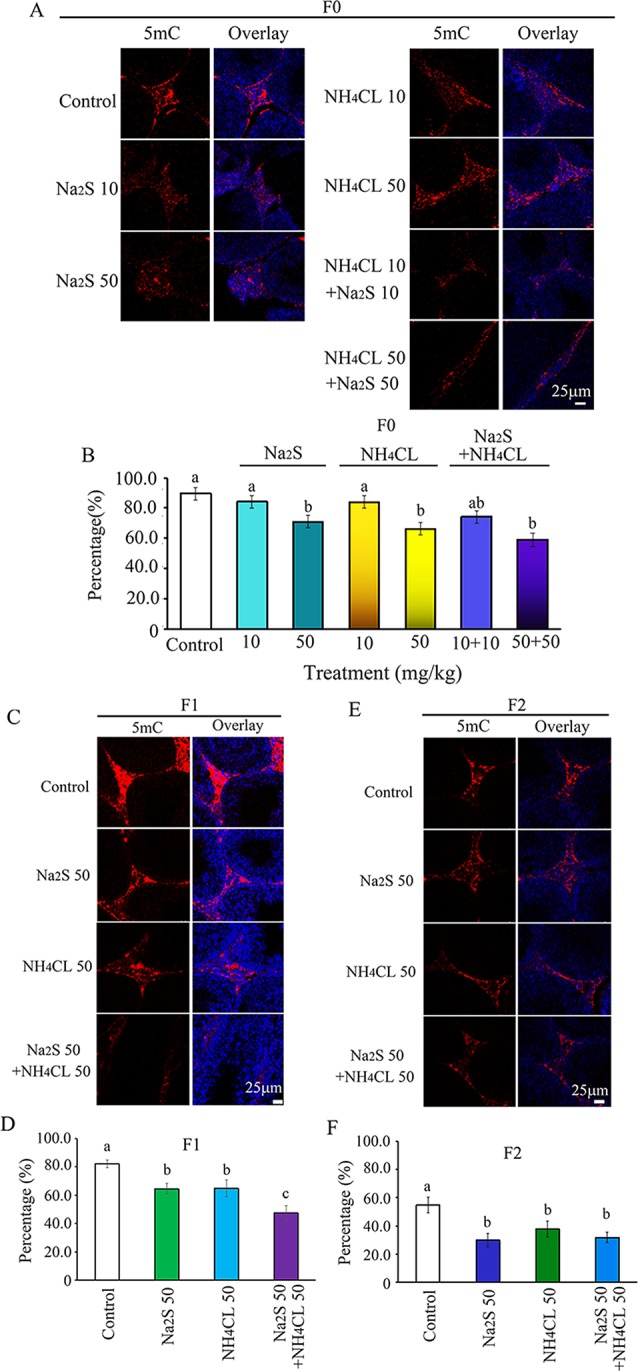
Protein 5mC in mouse testicular tissue as detected by immunofluorescence staining. (A) 5mC staining in F0 mouse testis. (B) Quantitative data for 5mC in F0 mouse testis. (C) 5mC staining in F1 mouse testis. (D) Quantitative data for 5mC in F1 mouse testis. (E) 5mC staining in F2 mouse testis. (F) Quantitative data for 5mC in F2 mouse testis. N > 6. a, b, c indicate a significant difference among different treatments (p < 0.05).